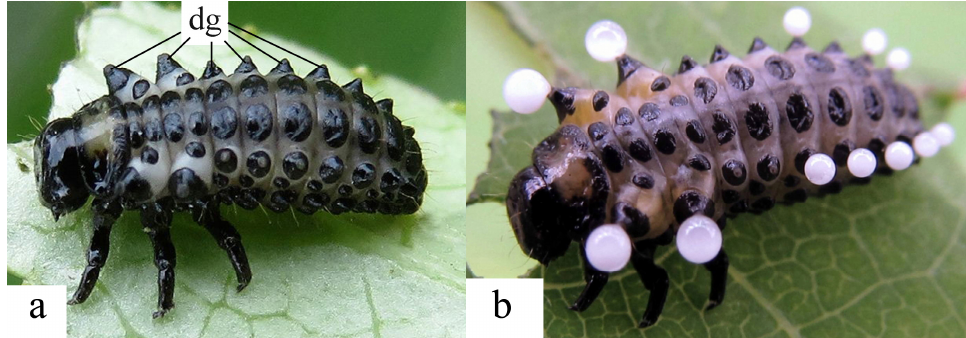
Figure 8. Larva of Chrysomela tremula Fabricius, 1787: ( a )—everted reservoirs of dorsal defensive glands (dg) are indicated; ( b )—defensive glands release droplets of secretions.